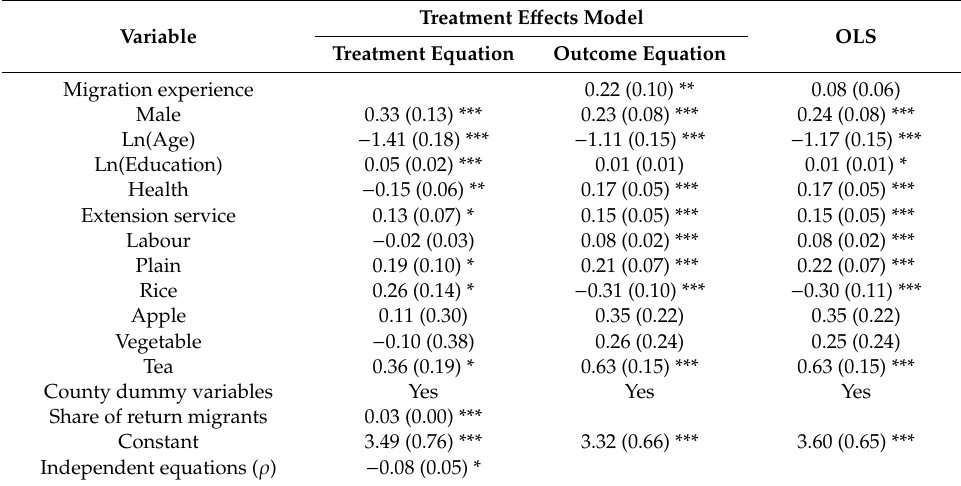
Table 4. The e ff ects of rural–urban migration experience on arable land